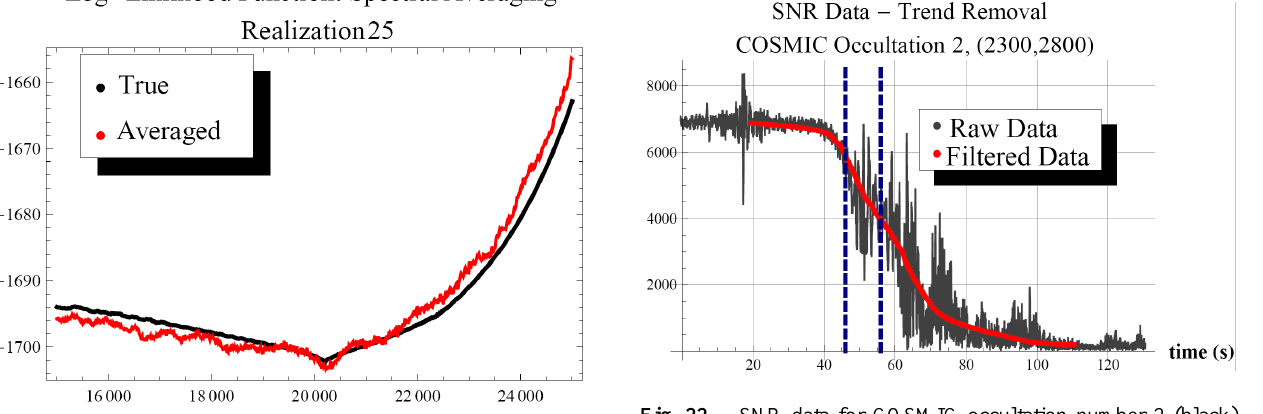
Fig. 20. Log-likelihood function, as a function of η 1 in km, derived from averaged and theoretical amplitude frequency spectra. Five spectra, beginning at realization 25, were averaged.